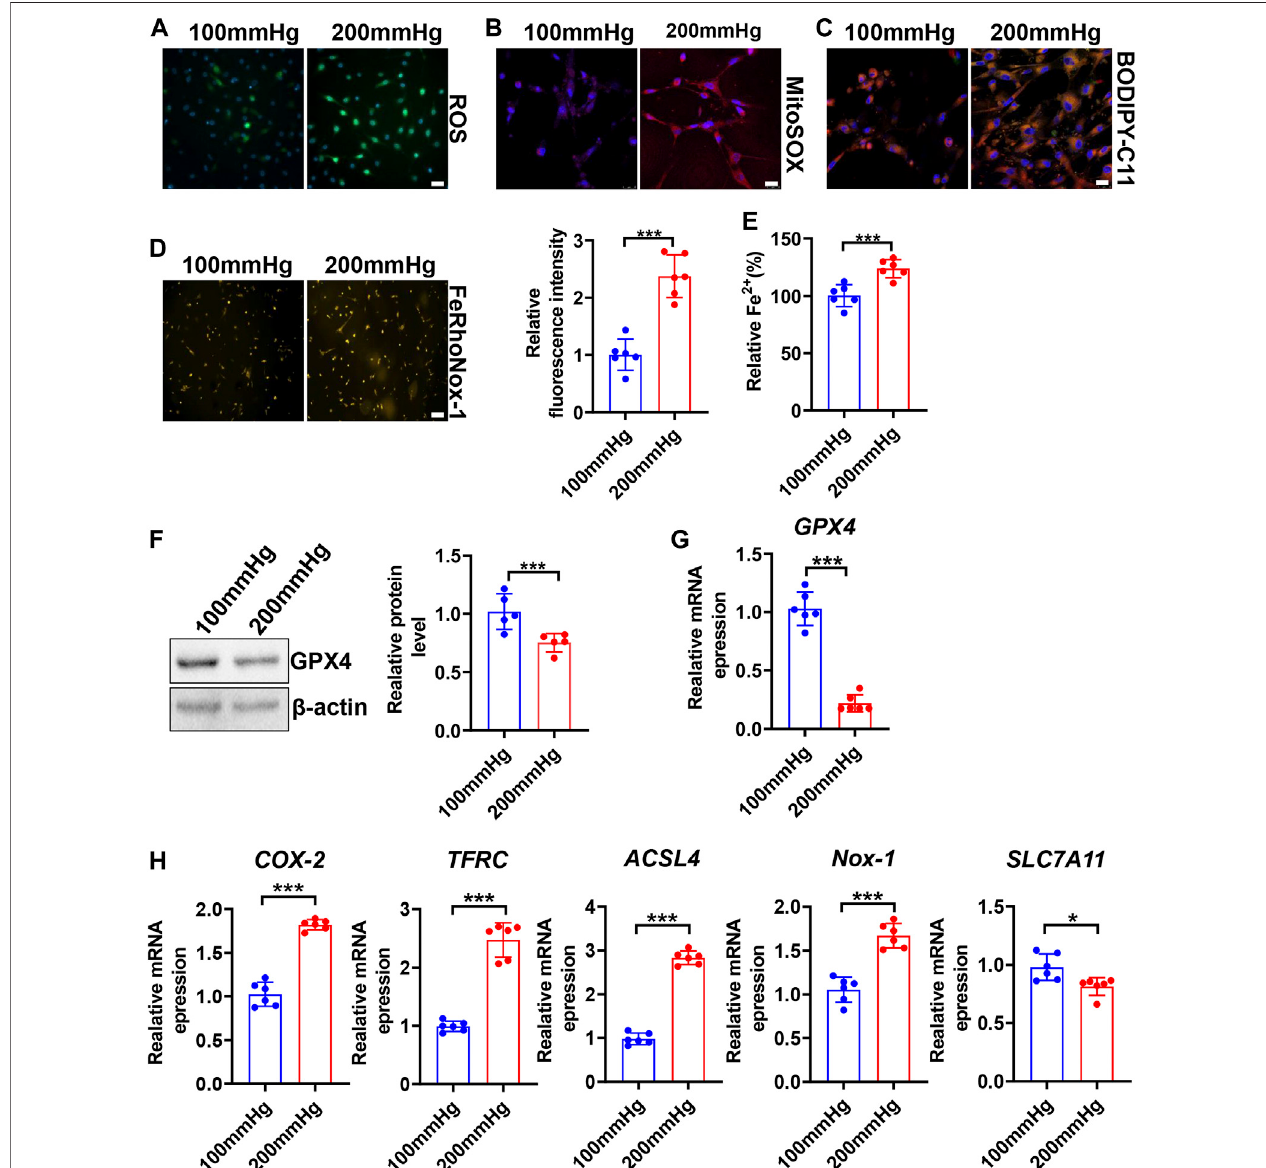
FIGURE 2 | High hydrostatic pressure promoted ferroptosis. HASMCs were treated with hydrostatic pressure for 24 h. Immuno fl uorescent staining of total ROS, scale bar = 50 µM (A) . MitoSOX Red staining of HASMCs for mitochondrial ROS, scale bar = 25 µM (B) . BODIPY-C11 staining measured the lipid peroxidation; orange indicated oxidized C11, scale bar = 25 µM (C) . Iron level was detected by FeRhoNox-1 staining (D) and iron assay kit (E) , scale bar = 100 µM. Western blot assay measured the GPX4 protein level; the left panel is the representative image, and the right panel is the statistical graph (F) . The mRNA levels of GPX4 (G) , COX-2, TFRC, ACSL4, NOX-1, and SLC7A11 were measured by real-time PCR (H) under HHP conditions. Nuclei were counterstained with Hoechst. * p < 0.05, *** p < 0.001.